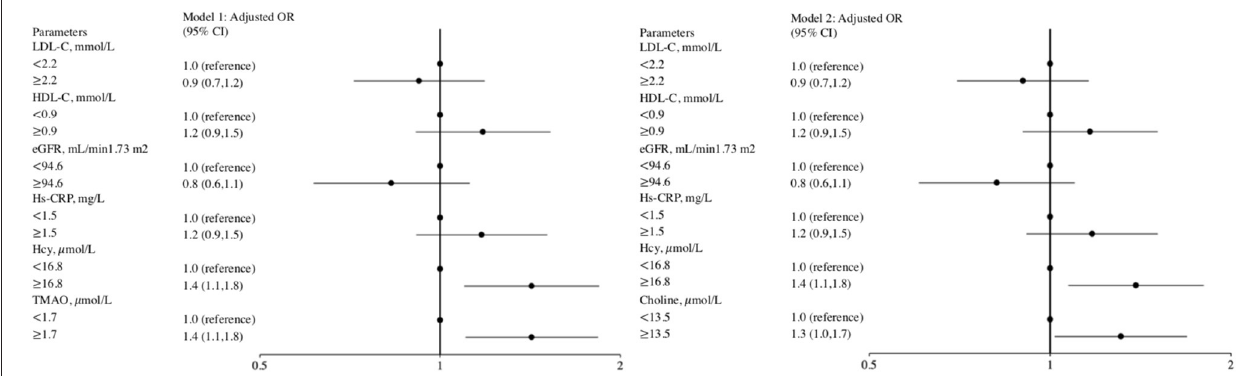
TABLE 2 | Relationships between plasma TMAO and choline concentrations and the risks of higher total, periventricular, and deep WMH burden. TMAO (range, µ mol/L) 1st quartile ( < 1.2) 1.0 (ref)